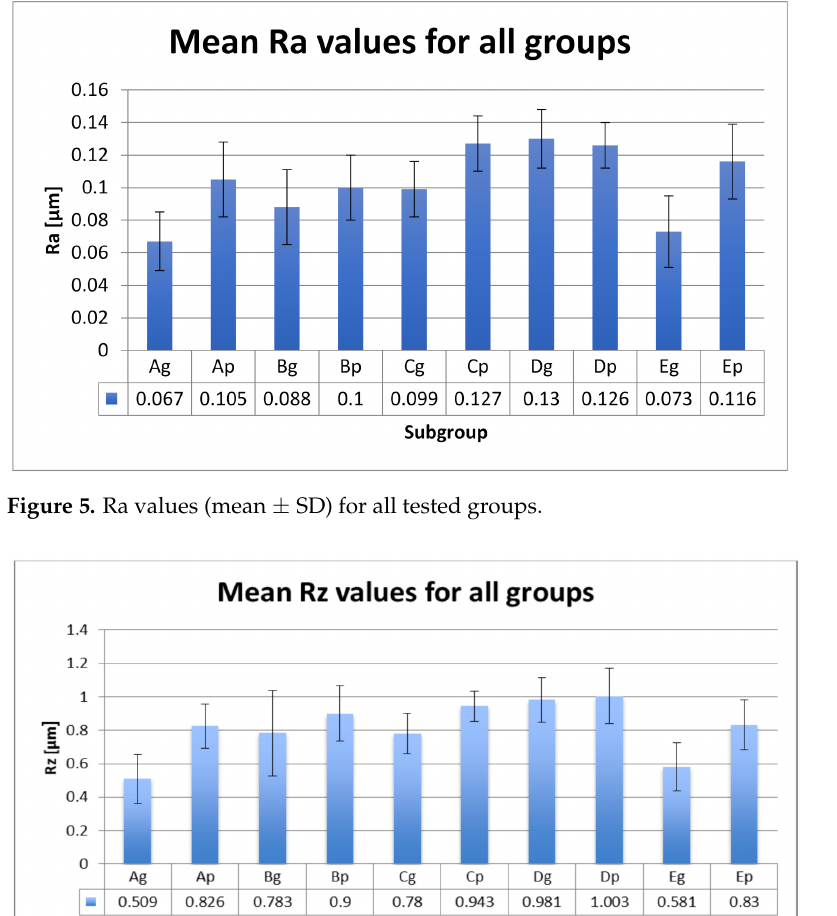
group aged by thermocycling and stained by thermocycling in coffee. The glazed